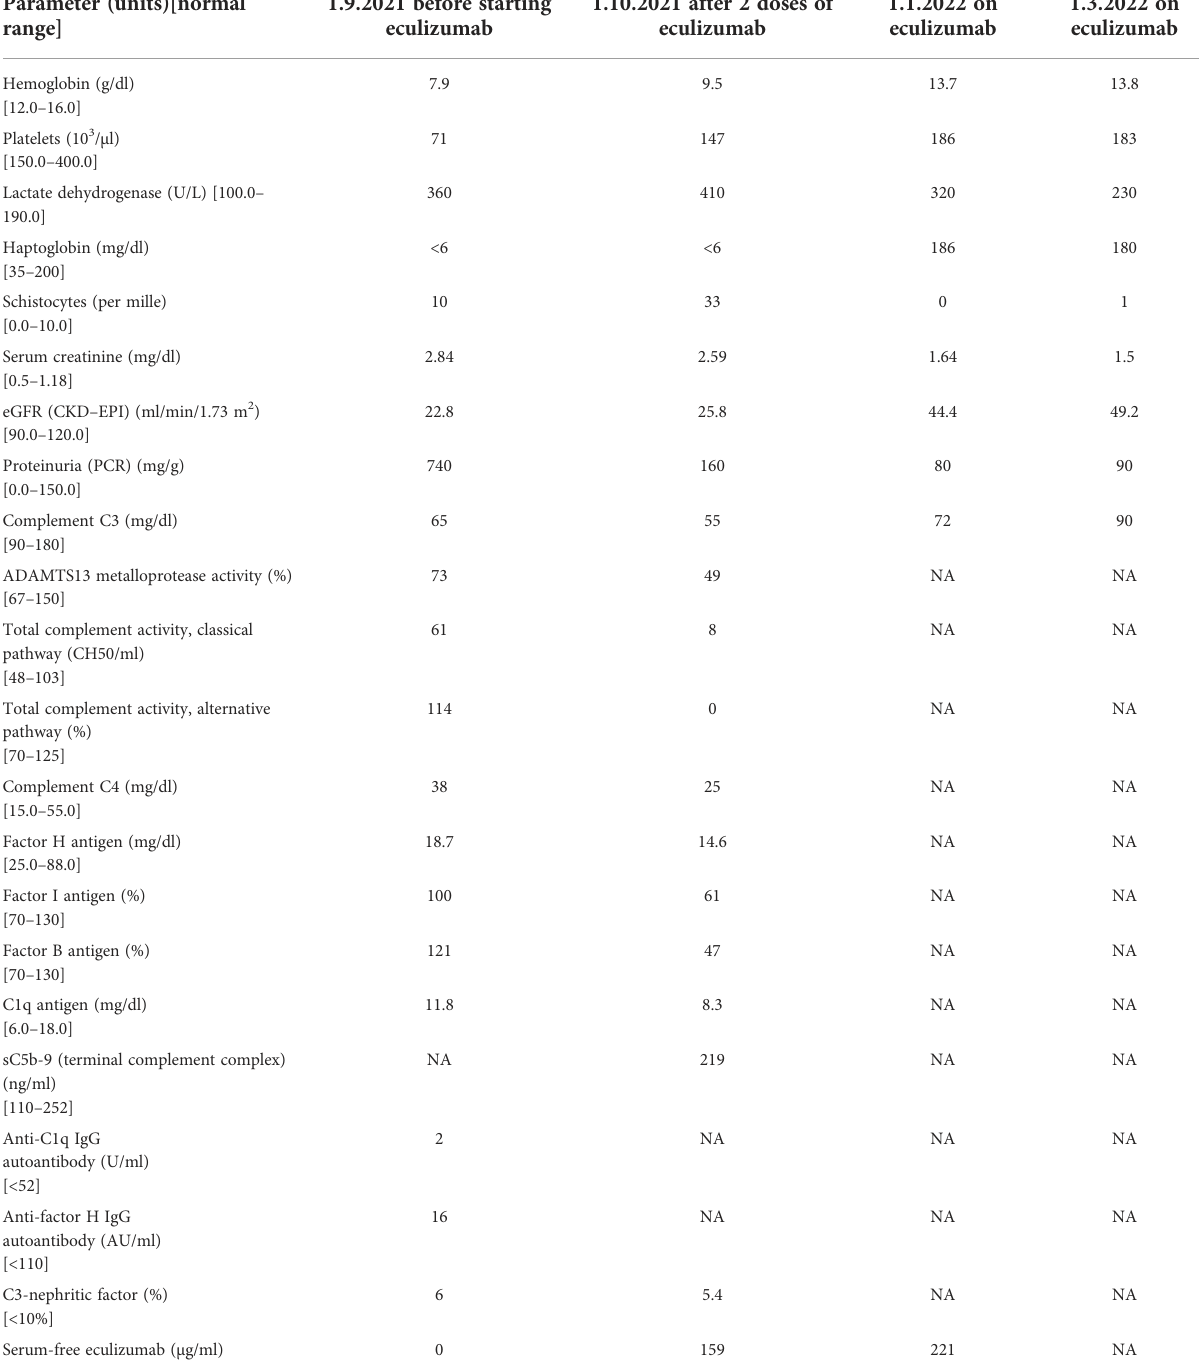
TABLE 1 Timeline of the laboratory results in our patient with CM-HUS before and after the eculizumab therapy initiation. Parameter (units)[normal